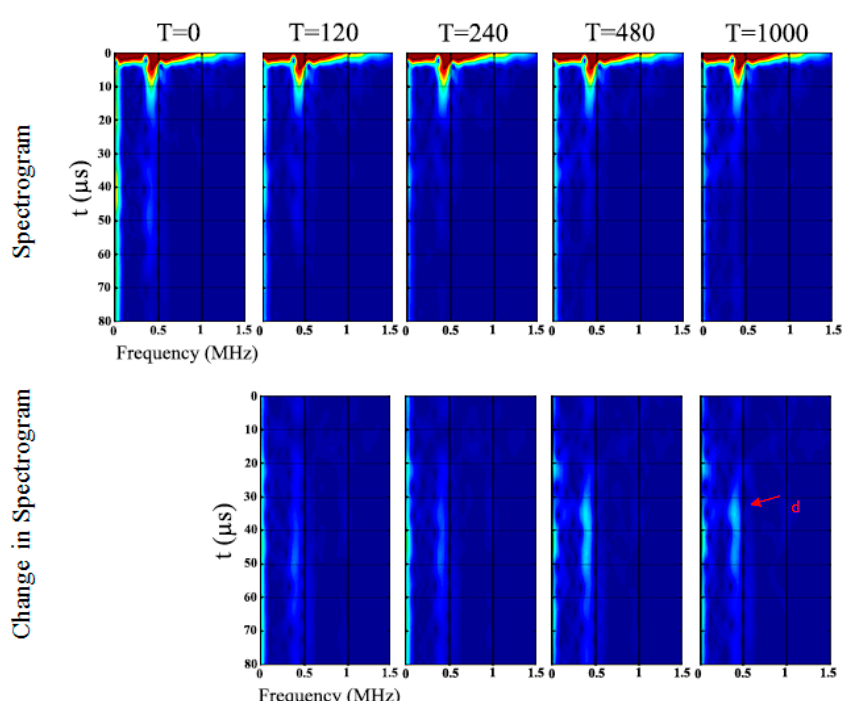
Figure 12. Triangular specimen (Near): Spectrogram and changes in spectrogram for each cure time